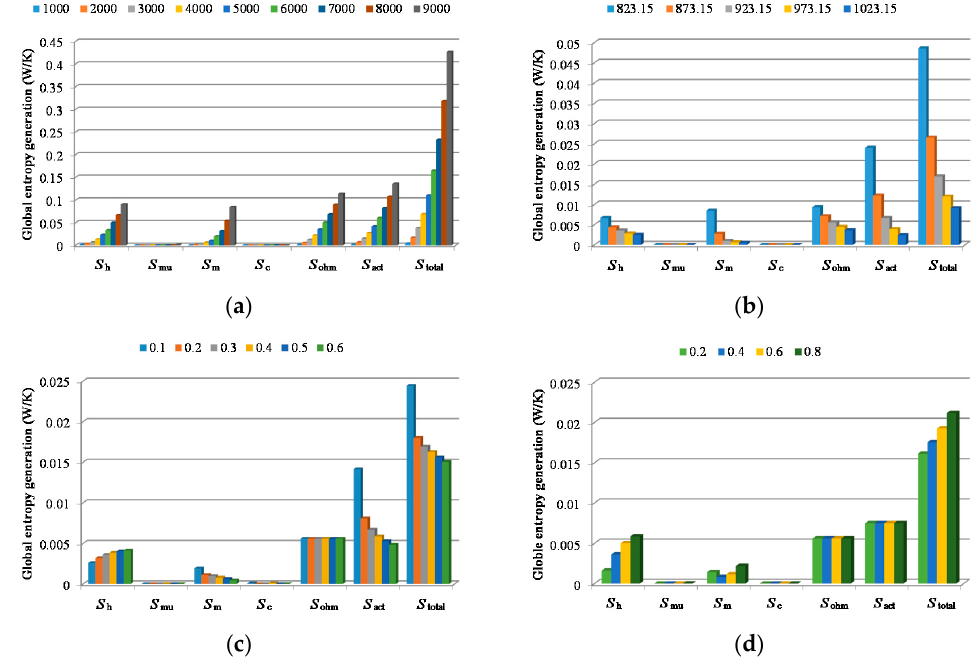
Figure 10. Global entropy generation for: ( a ) different current densities (A/m 2 ); ( b ) different working temperature (K); ( c ) different CO 2 concentrations; ( d ) different cathode CO 2 gas utilization rates.